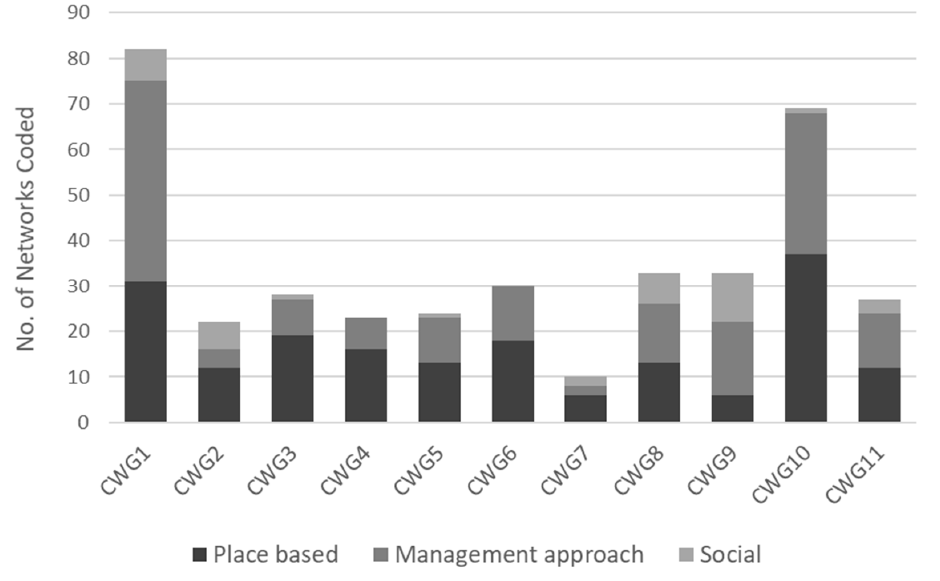
Figure 2. Count of Networks Referenced by CWGs.